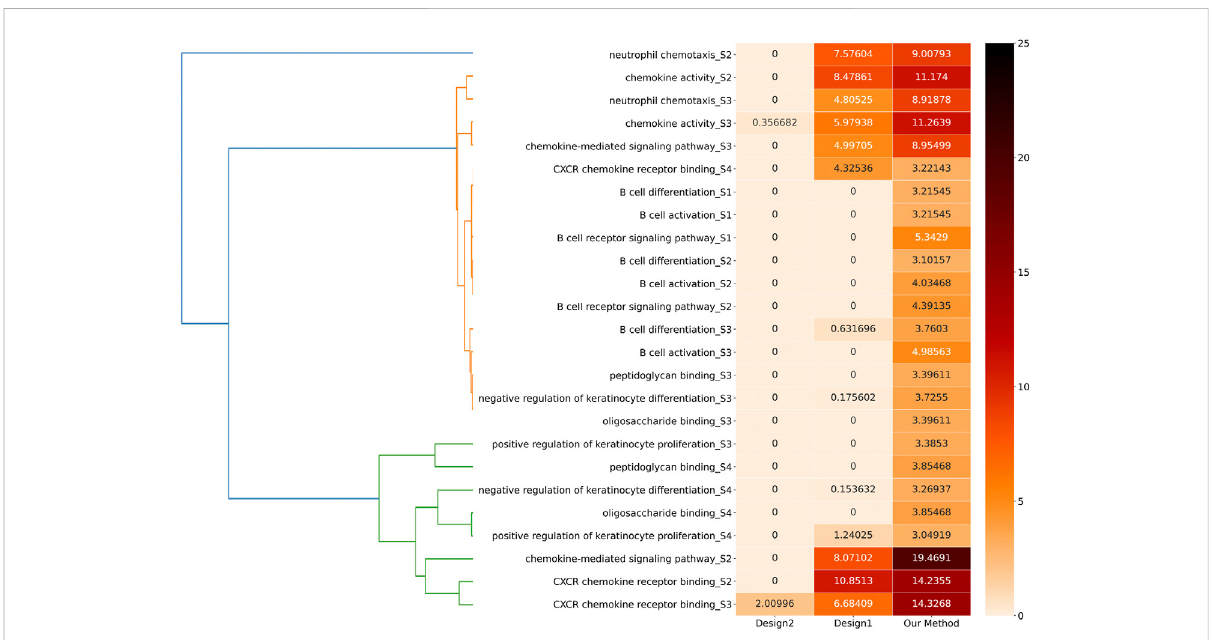
FIGURE 14 Effectiveness comparison of the three methods. In the heat matrix, we take Q ′ = − ln q as the comparative index and some biological functions cannot be found in the corresponding enrichment information in some methods. We use 0 to represent absence or a q -value equal to 1.0; thus, the larger the value of Q ′ , the smaller the q -value and the darker the